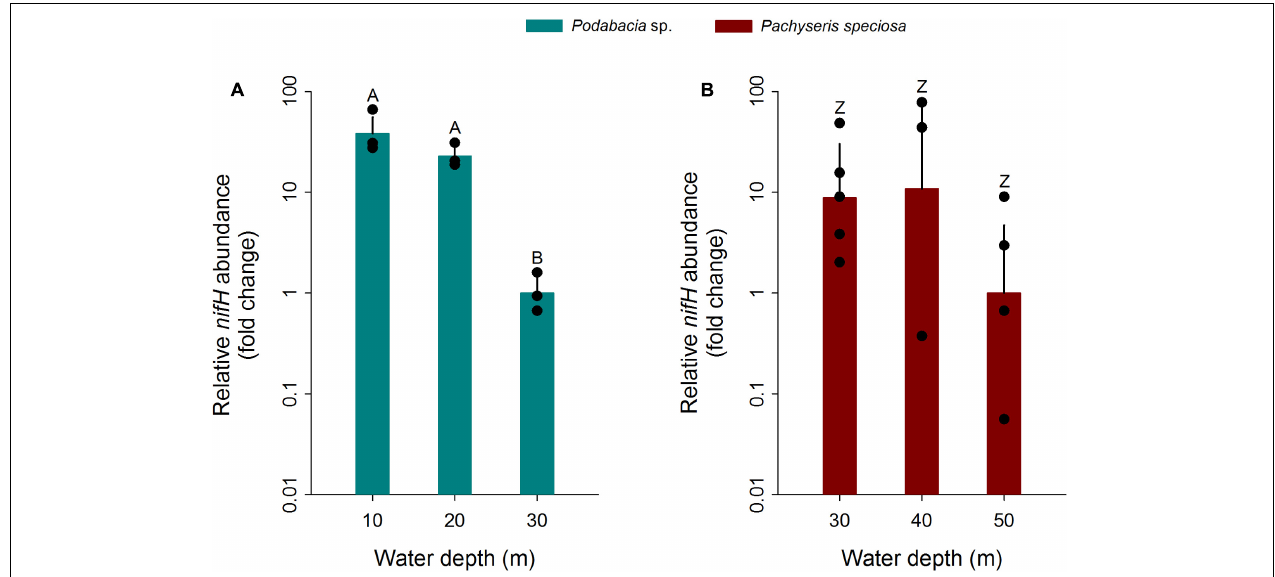
FIGURE 1 | Fold changes in relative nifH gene copy numbers normalized to 16S rRNA gene copy numbers in the tissues of two Red Sea scleractinian corals (A) Podabacia sp. and (B) Pachyseris speciosa ( n = 3–5) depending on water depth. Fold changes were calculated in relation to the greatest collection depth of the respective species; error bars indicate upper confidence intervals (+ 1 SE). Black circles represent data points. Different letters above bars indicate significant differences within species ( p < 0.01). As both corals were collected at different depths (limited overlap only at 30 m), direct comparisons of relative nifH gene abundances between both species were precluded.